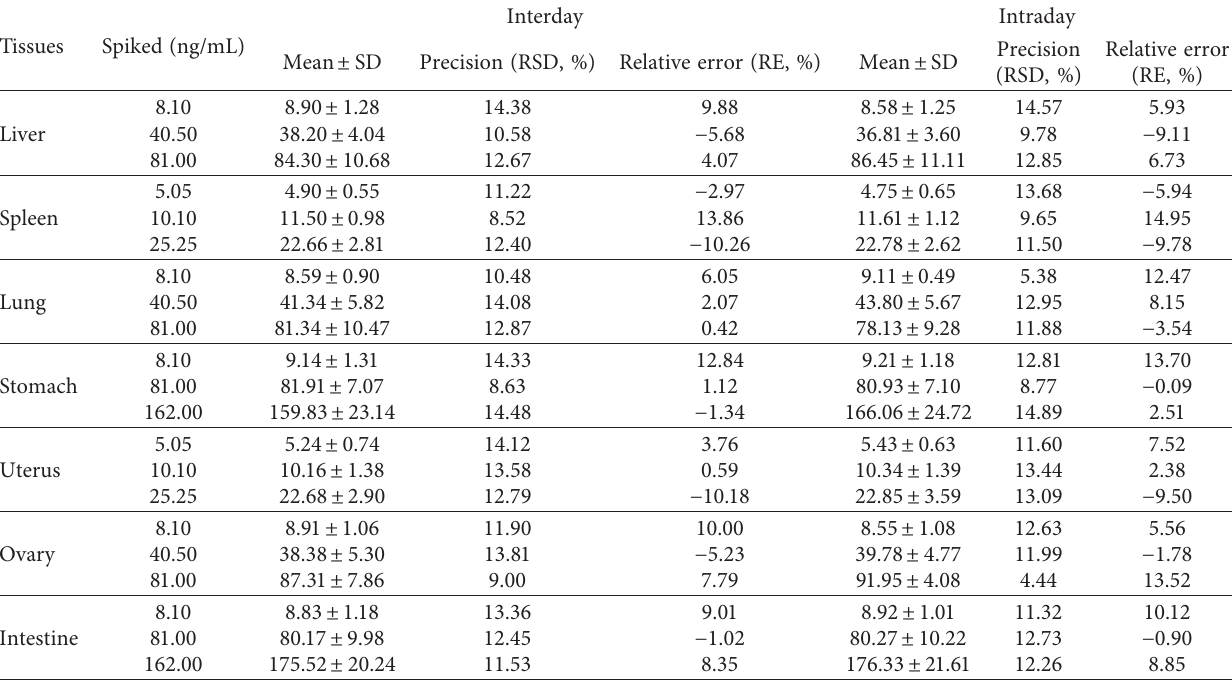
Table 7: Interday and intraday precision and accuracy data for assays of eriodictyol in different tissues ( n � 6).